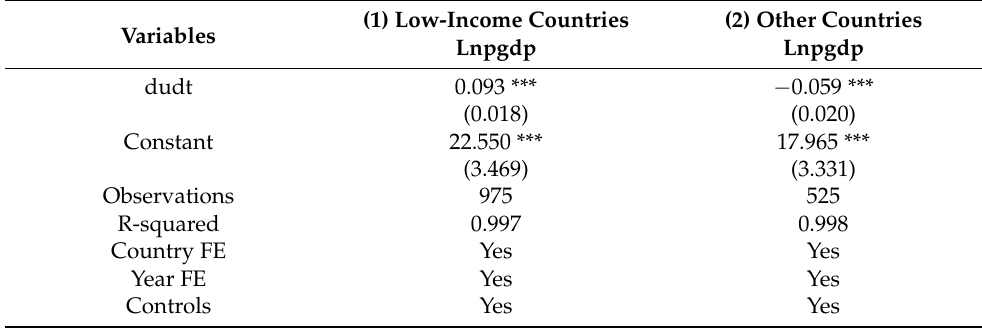
Table 7. Distinguishing between “low income” and “other countries”.